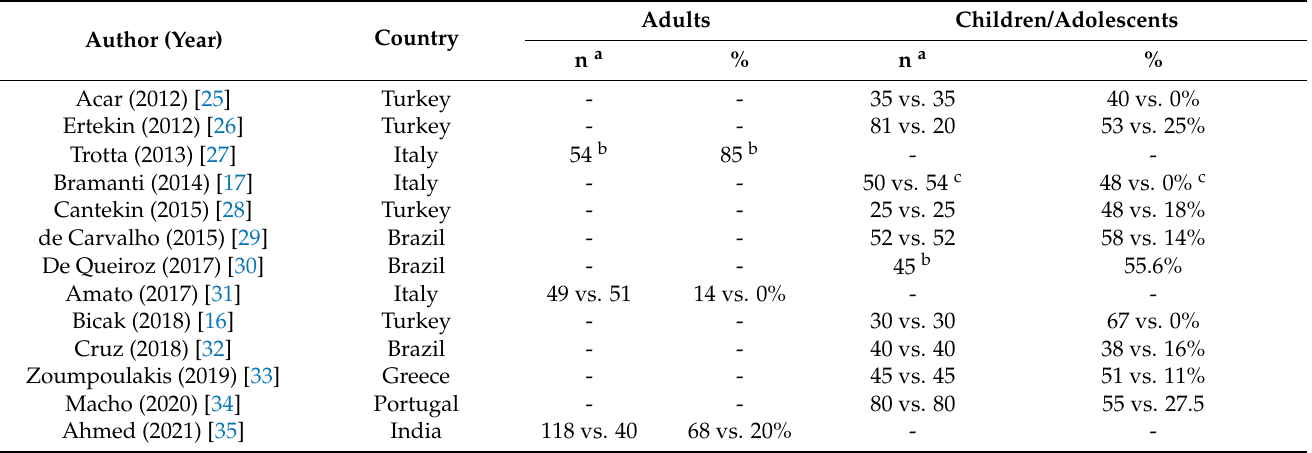
Table 3. Frequency [%] of dental enamel defects (CeD patients vs. controls).